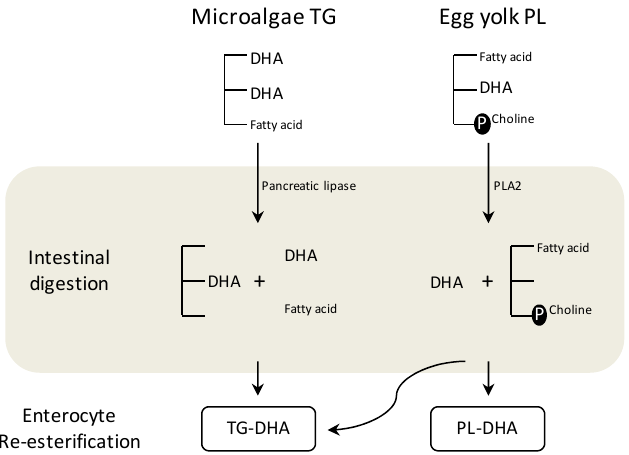
Figure 2. Intestinal digestion of dietary docosahexaenoic acid (DHA) ingested as phospholipids (PL) from egg yolk or triglycerides (TG) from microalgae oil schematic. PLA2, phospholipase A2.